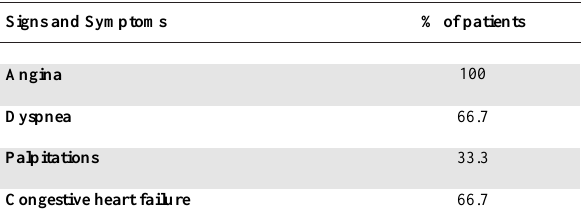
Table 1. Signs and symptoms in patients with isolated coronary artery